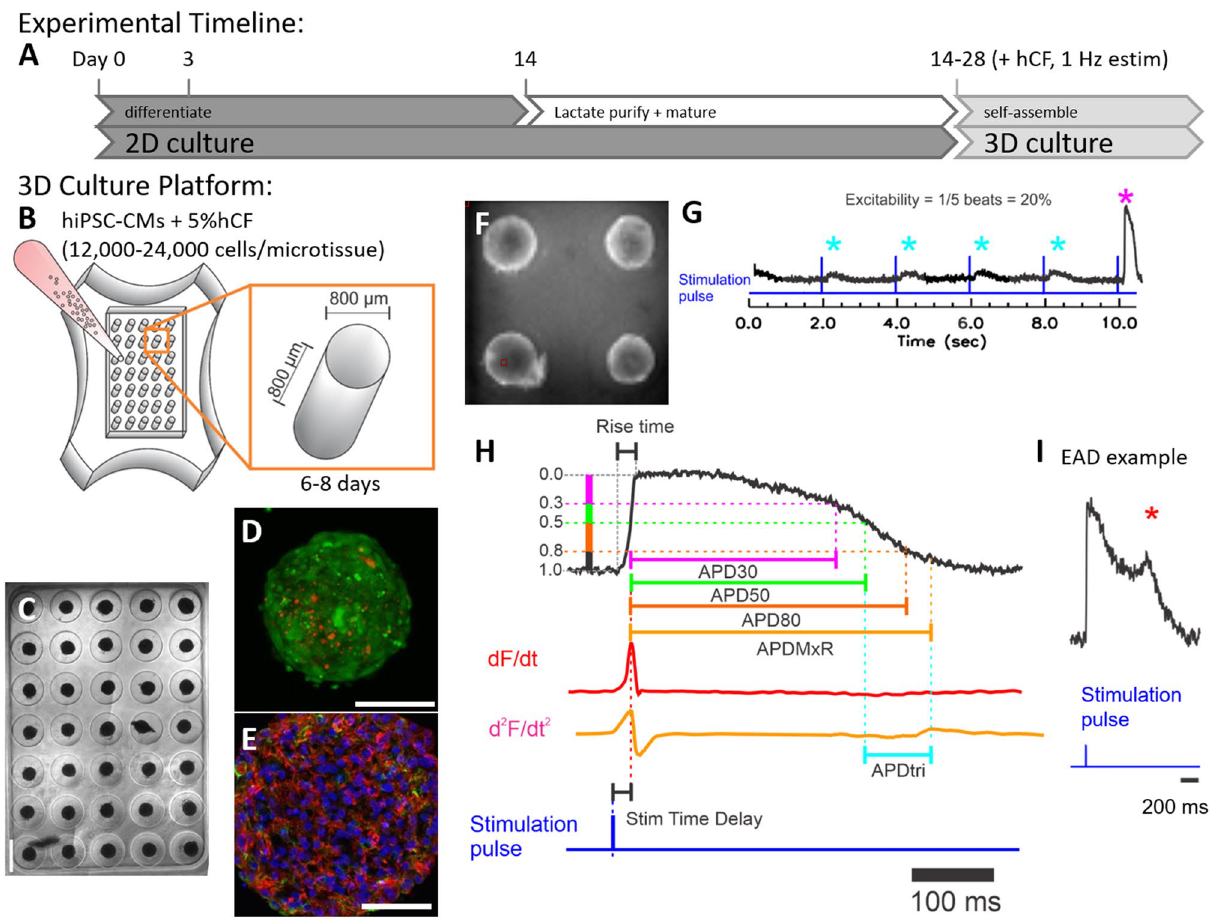
Figure 1. Differentiation of hiPSC-CM, formation of cardiac microtissues, and definitions of metrics. ( A ) Timeline shows cardiomyocyte differentiation from human-induced pluripotent stem cells (hiPSCs) in high density 2D culture. Cardiac directed differentiation was achieved with Wnt activation at day 1 and inhibition at day 3 (see “Methods”). Cardiac phenotype, visually confirmed by beating cells, appeared between days 8 and 12. Cardiomyocytes differentiated from hiPSCs were used for the production of microtissues or were further purified with a lactate-based metabolic selection protocol. Microtissues self-assembled in microwells after 14–28 days of differentiation of hiPSC-CMs (i.e., without or with lactate purification) and addition of human cardiac fibroblasts (hCFs), and they were cultured in the presence of 1 Hz electrical field stimulation (estim). ( B ) Schematic of three-dimensional (3D) cardiac microtissue generation shows non-adhesive agarose gels with cylindrical recesses with hemispherical bottoms that guide self-assembly. Cardiac microtissues were cultured for 6–8 days with 1 Hz pacing. ( C ) Phase contrast image shows consistent spherical microtissue formation after 5 days of 3D culture in all 35 microwells. Scale bar, 800 μm. ( D ) Confocal image shows a representative cardiac tissue with hiPSC-CM (green) and hCF (red) stained with CellTracker dyes. Scale bar, 200 μm. ( E ) Confocal image shows a representative cardiac troponin I (red), vimentin (green), and DAPI stained cryosection (10 μm thick) of a microtissue fixed after 7 days in 3D culture. Scale bar, 50 μm. ( F ) Fluorescence image of microtissues at 3.2 × magnification was obtained during optical mapping. Typically, the action potentials (APs) from 4–9 microtissues were recorded simultaneously. ( G - I ) Schematics of the AP metrics of that were defined (with units) as: ( G ) “excitability” (%) measured from the percentage of captured APs during 10 s duration of recording with 2 s pacing cycle length, ( H ) “stimulation time delay” (ms; stim delay) between stimulation pulse and evoked AP upstroke (dF/dt max ), “rise time” (ms) of AP, “AP duration” (ms) to 30%, 50%, and 80% repolarization (APD 30 , APD 50 , APD 80 ), “APD to the maximum repolarization rate” (ms; APD MxR ) defined as time between AP upstroke and the end of rapid repolarization marked by d 2 F/dt 2 max , “APD triangulation” (ms; APD tri ) defined as APD MxR — APD 50 , and ( I ) occurrence of “early afterdepolarization” (EAD) reported as (%) of microtissues showing 5d. Use of CellTracker dyes to label hiPSC-CM (green) and hCF (red) prior to assembly as well as immunostain- ing with antibodies against cardiac troponin I (cTnI) and vimentin (vim) after fixation and sectioning confirmed that hiPSC-CMs and hCFs self-assembled to be highly interspersed (Fig. 1D,E), consistent with our prior work in rat cardiac microtissues 35,36 .